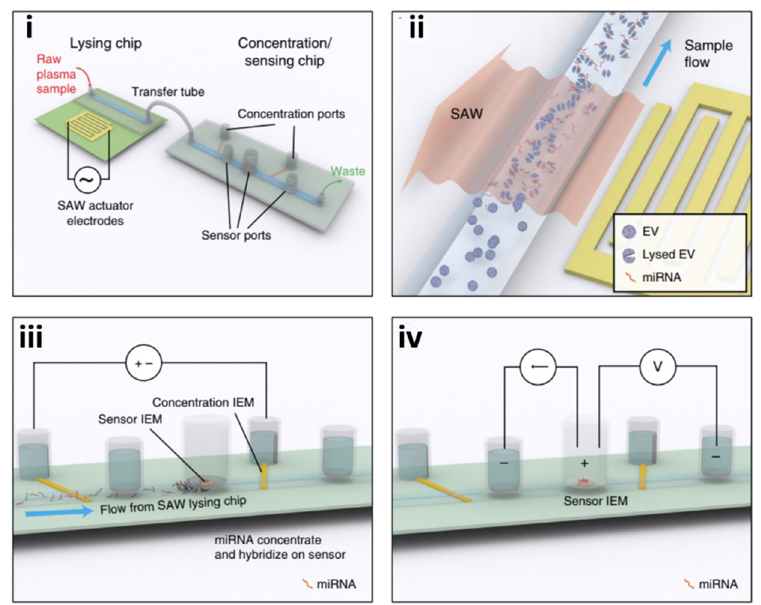
Figure 8. Example of the on-chip lysing method for the detection and profiling of exosome content. Schematic of the integrated microfluidic platform that features two chips , ( i ) and ( ii ) one for exosome mechanical lysing with surface acoustic waves (SAW) and ( iii ) and ( iv ) enrichment followed by a sensing chip for exosome contents for disease profiling (reprinted with permission from Ramshani et al. 2019 under Springer Nature from the Copyright Clearance Center).